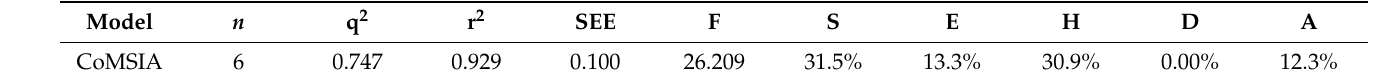
Table 3. PAEs’ molecular comprehensive effects CoMSIA model evaluation parameters and molecular field contribution rate